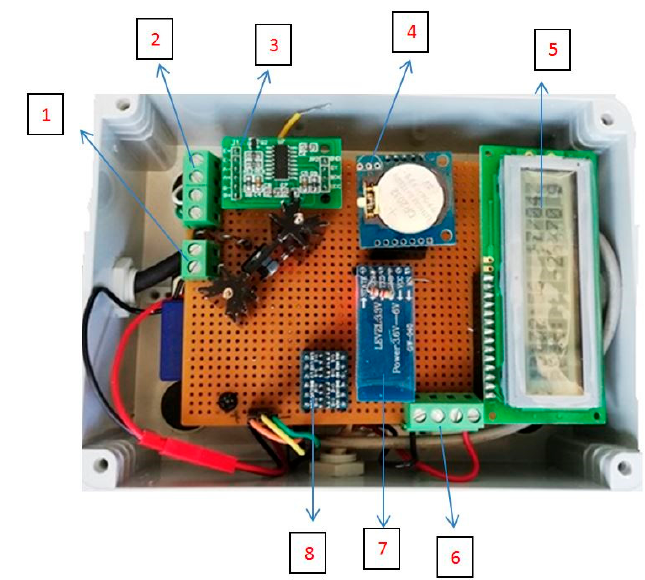
Figure 1. Arduino platform (1) external 12 V DC power supply connector; (2) load cell connector (and bridge power supply outputs and two bridge unbalance measurement inputs); (3) HX711 load cell amplifier; (4) real time clock DS1307; (5) Hitachi 16 × 2 display; (6) 12 V output for anemometer / vane power supply and two measurement inputs; (7) HC05 Bluetooth module; (8) level translator for SD card level converter 3.3 V/5 V.